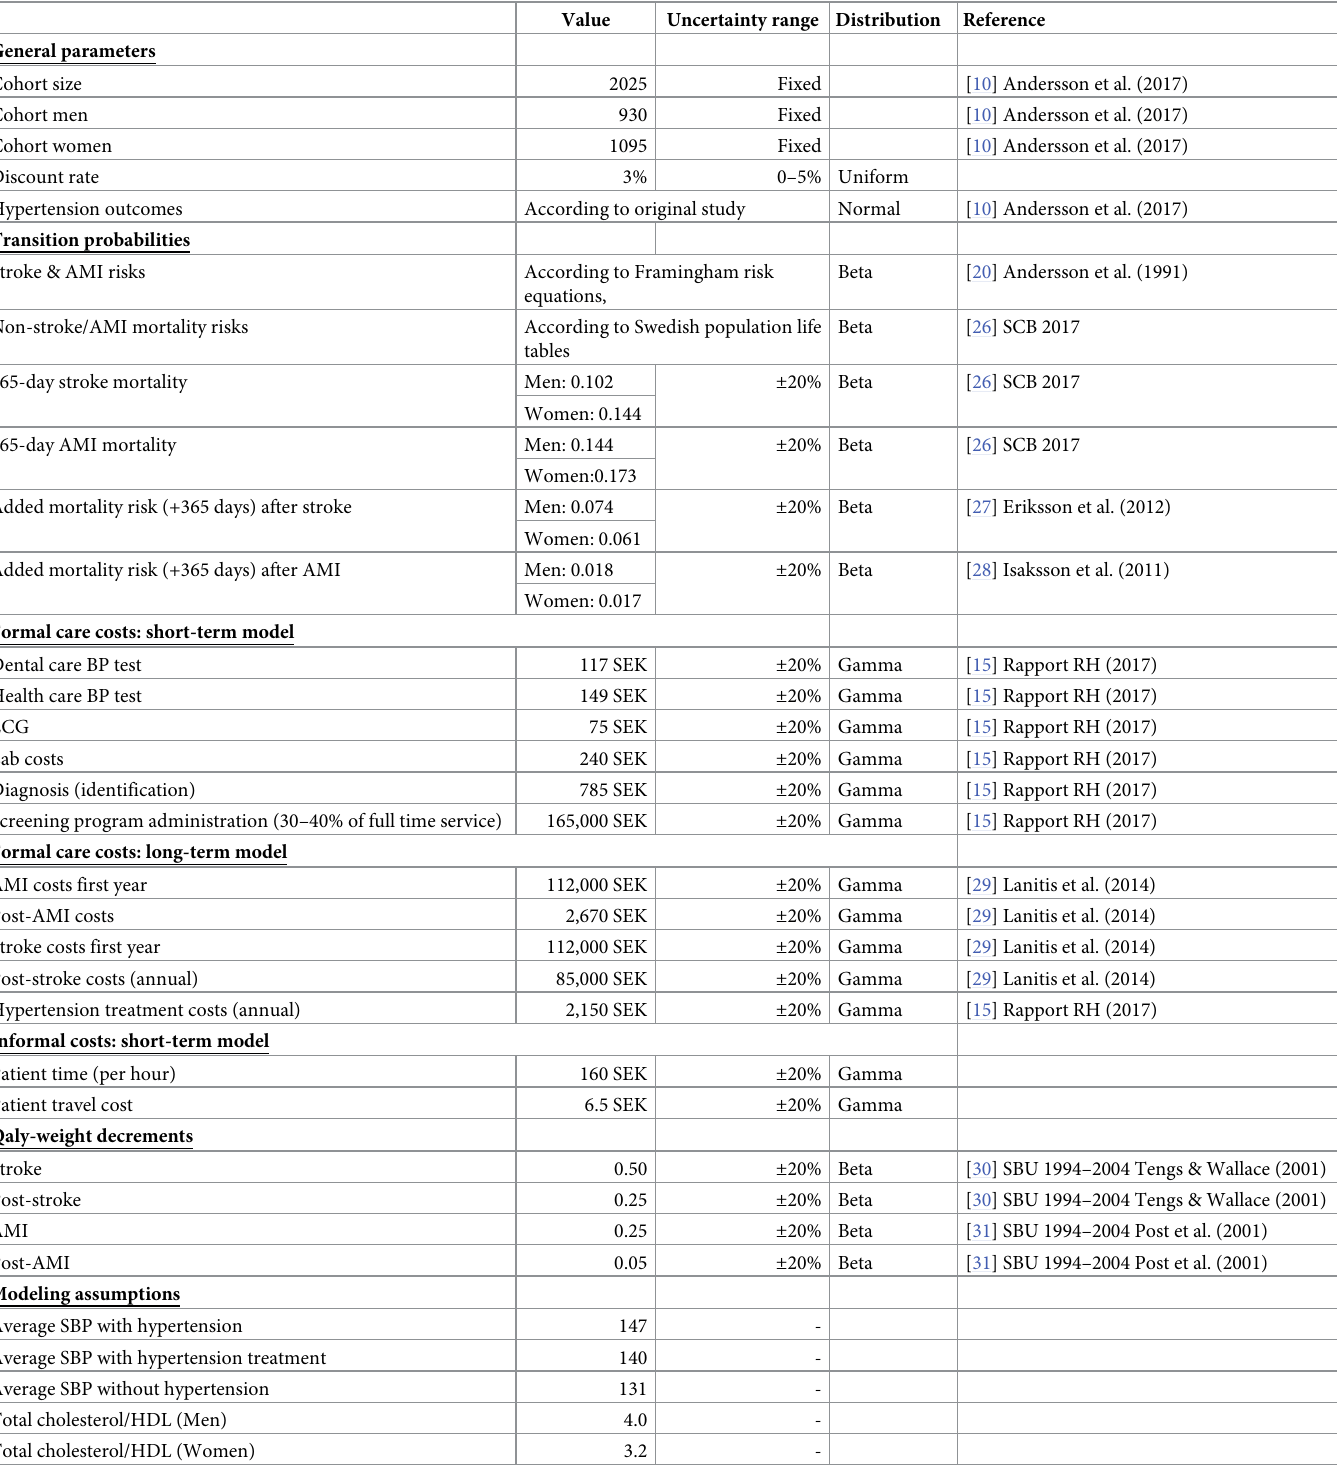
Table 1. Input data on costs and health